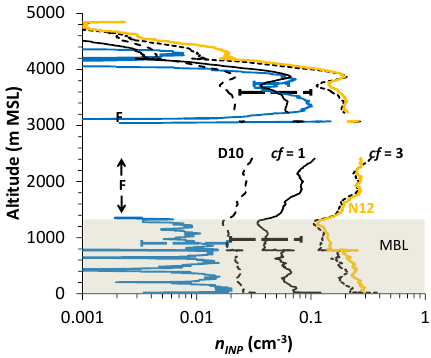
Figure 11. Comparison of ice nucleation data and parameterizations for data collected onboard the NSF/NCAR C-130 aircraft during the ICE-T study descent sounding through a Saharan dust layer shown in Fig. 4. CFDC INP data plotted as a 30s running average at ambi- ent conditions are given by the blue trace, the D10 parameterization is the long-dash trace, the solid black trace labeled cf = 1 is the un- calibrated parameterization derived using Eq. (2) ( α = 0, β = 1.25, γ = 0.46, and δ =− 11.6), and the short-dash trace labeled cf = 3 is the calibration-corrected parameterization with the same coef- ficients, both also corrected from STP (standard temperature and pressure) to ambient INP concentrations. Uncertainties represent- ing twice the Poisson sampling error of the 30s running average data are given at two altitudes, and the standard errors of the cf = 3 prediction are shown at two nearby altitudes. Plotted for compari- son is the parameterization of Niemand et al. (2012), using aerosol surface area and CFDC processing temperature as input. CFDC pro- cessing temperature cooled from 248K at 5km to 246K at landing, while CFDC calculated RH w at the lamina position was maintained at 105 ± 0.5%. The shaded region represents the marine boundary layer (MBL). Label F indicates that CFDC sample air was being fil- tered. The data gap is when CFDC flow was shut off to remove an ice crystal